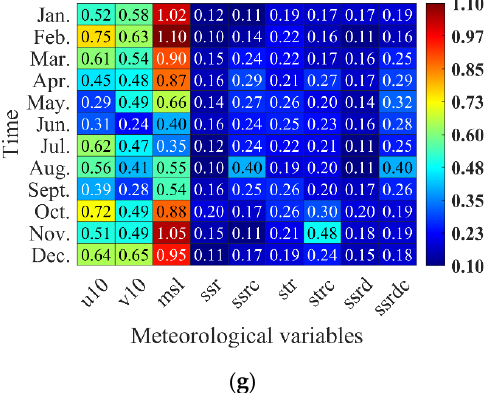
Figure 11. Heat map of mutual information for each meteorological variable and SST for the seas around China in different months ( a ) Bohai Sea and north part of Yellow Sea, ( b ) South part of Yellow Sea, ( c ) Part 1 (ID:3 in Table 1) of East China Sea, ( d ) Part 2 (ID:4 in Table 1) of East China Sea, ( e ) Part 1(ID:5 in Table 1) of Taiwan Strait, ( f ) Part 2(ID:5 in Table 1) of Taiwan Strait, and ( g ) South China Sea.